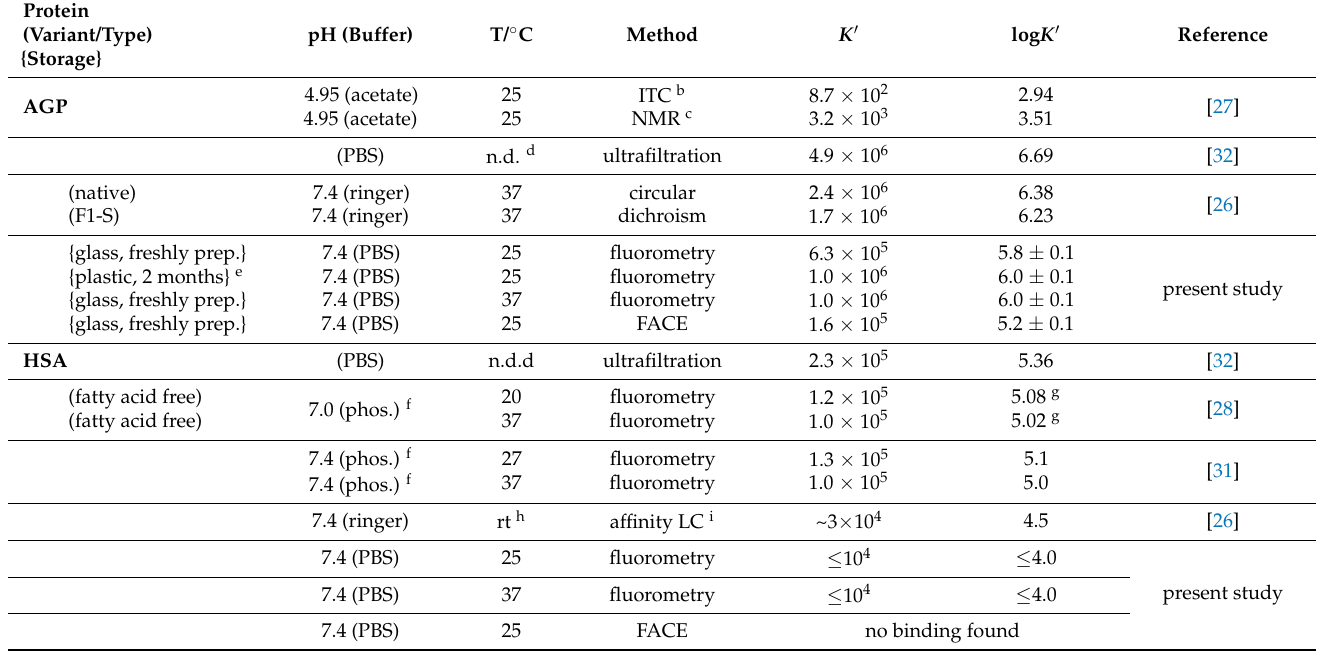
Table 3. Binding constants ( K (cid:48) ) reported in the literature and determined a in this study for the AGP–IMA and HSA–IMA systems under the indicated conditions.